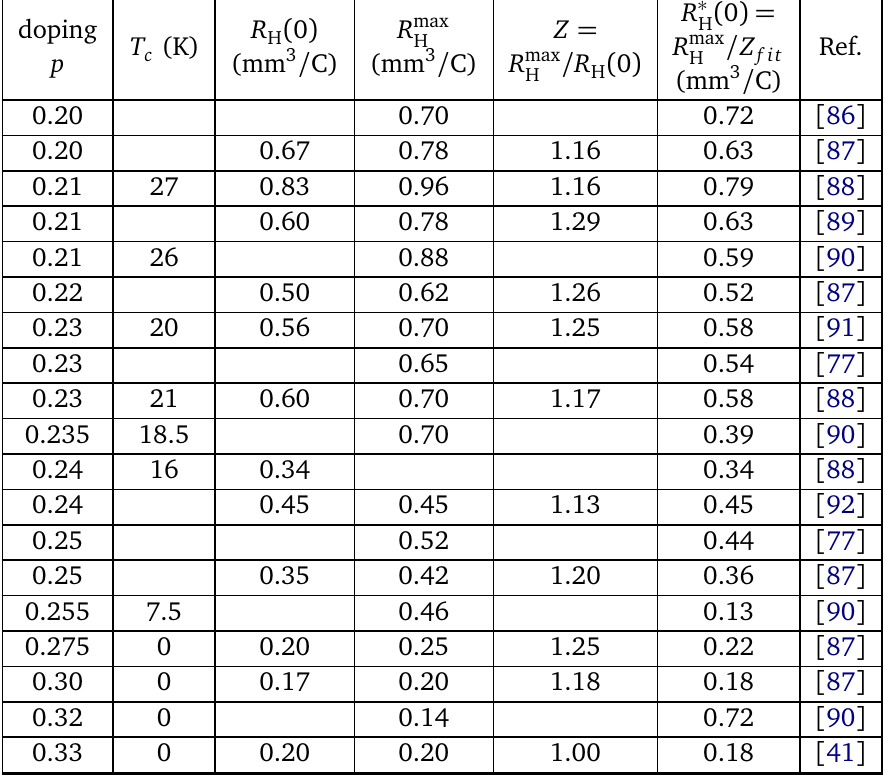
( 0 ) for OD LSCO obtained from the literature. In Table 8: Experimental values for R H samples where T values were reported, the p values were obtained using the stan- c ( p ) relation [ 93 ] . In others, the p values are as given. Low- T values dard parabolic T c ( 0 ) , where reported, are listed. For those where only maximum R R H ( 0 ) values were estimated by fitting the ratios Z = R max were plotted, R H other samples as a function of p , then using the (linear) fit to this ratio to estimate ( 0 ) ∗ from R max / Z R . Using the same fit to ‘re-engineer’ R f it H H ( 0 ) was already known shows that the fitting routine reproduced the for which R H ( 0 ) values to within 10 %. All extracted values for R as-measured R H were subsequently binned into p steps of 0.01 (or higher) and plotted in Fig.